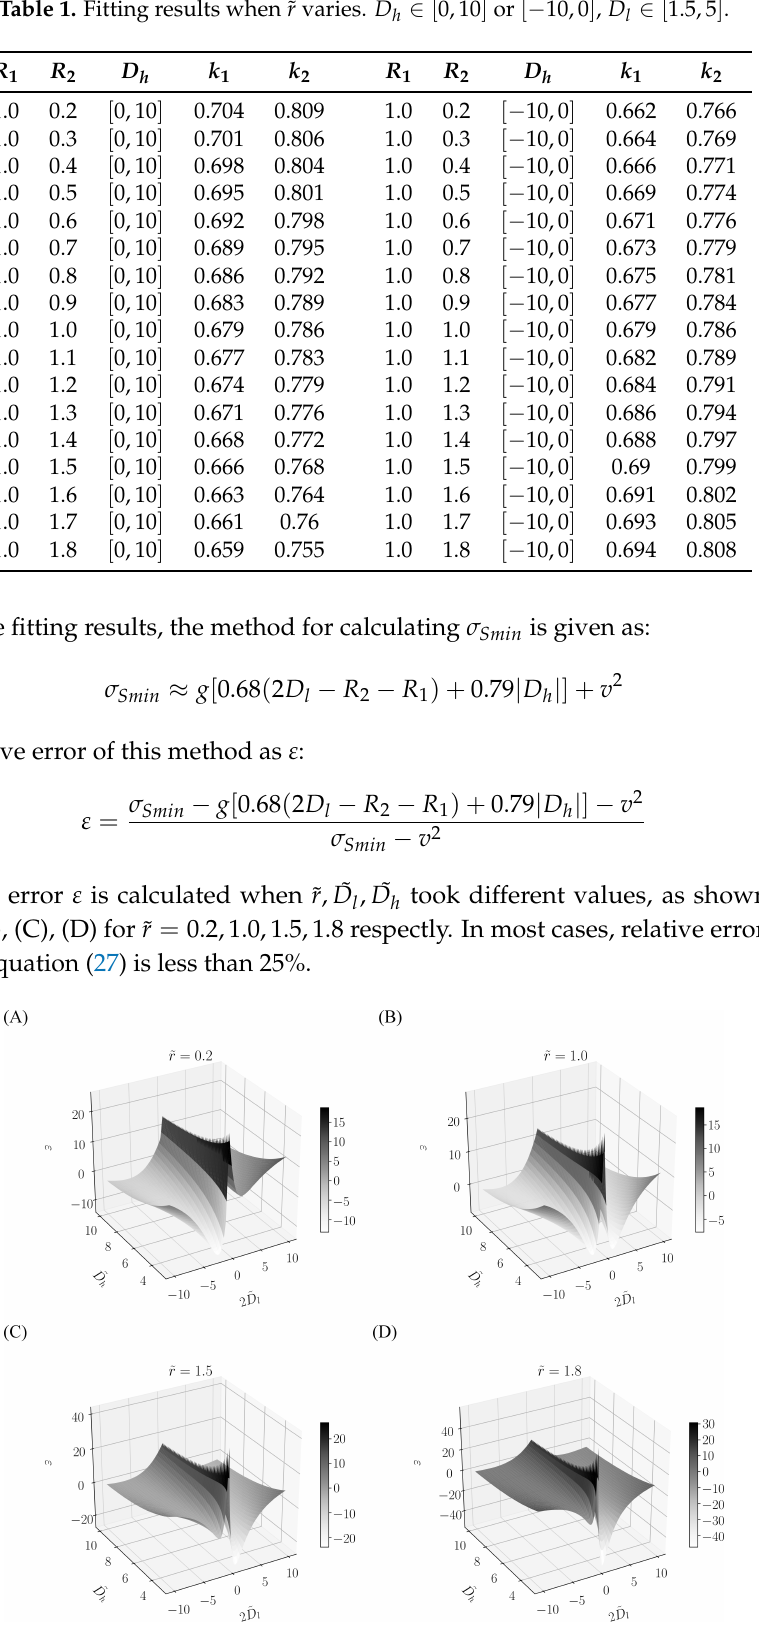
Table 1. Fitting results when ˜ r varies. D h ∈ [ 0,10 ] or [ − 10,0 ] , D l ∈ [ 1.5,5 ] .